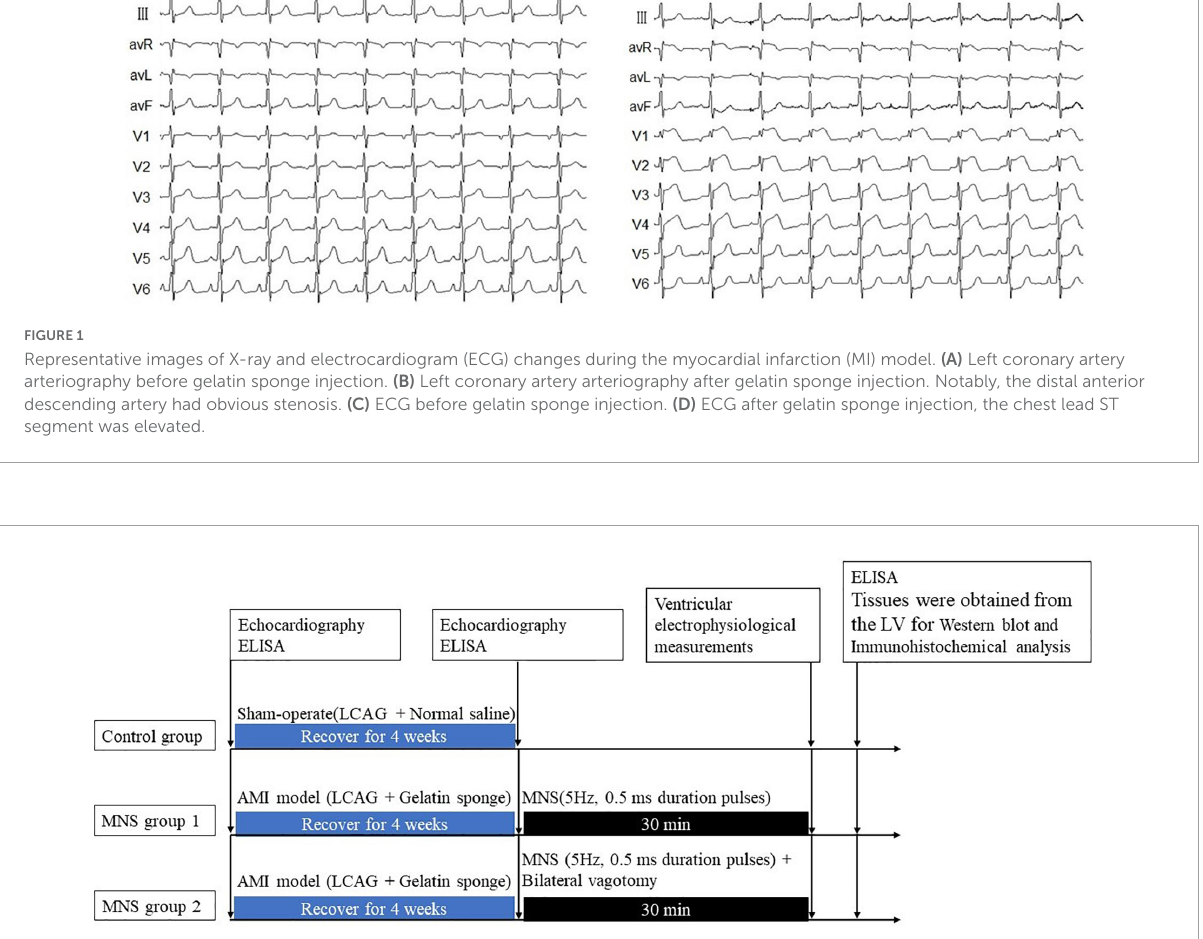
Frontiers in Cardiovascular Medicine